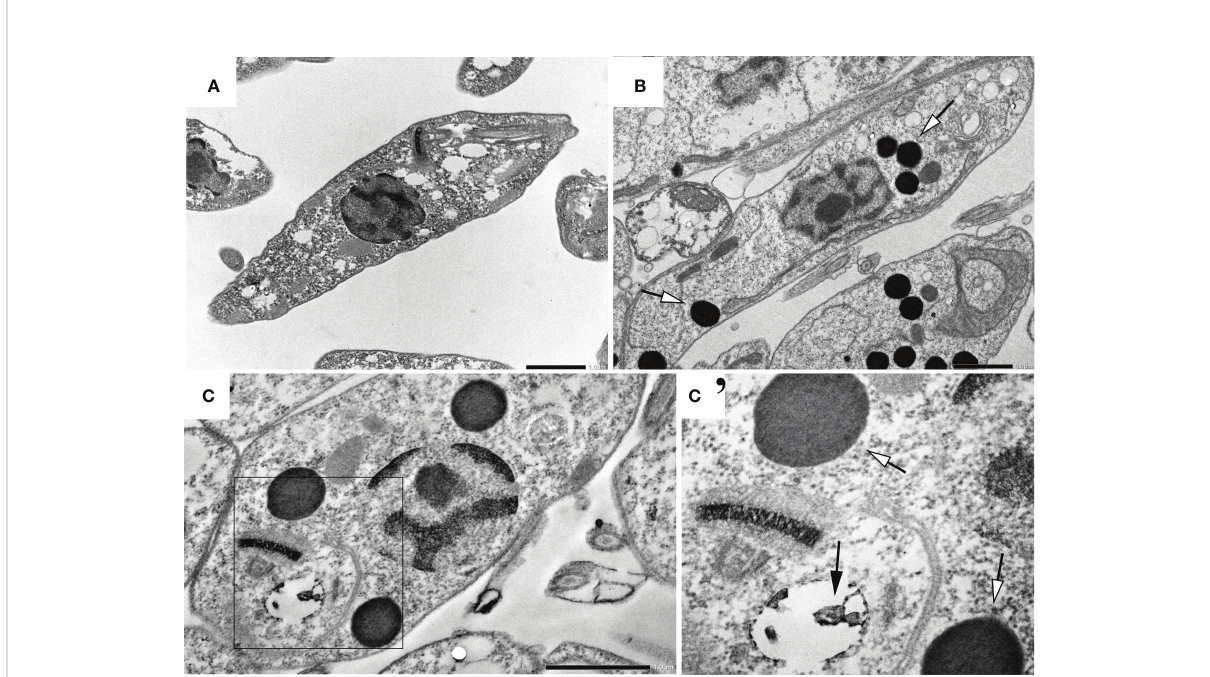
FIGURE 5 Ultrastructural analysis of L. amazonensis promastigotes treated with AmpB and TCBZ. (A) Non-treated parasites. (B) Parasites treated with AmpB IC 50 showing large electrondense vesicles (pointed by white arrowheads). (C) Parasites treated with TCBZ IC 50 . (C ’ ) Enlargement of the demarked area of Figure 3C where treated cells seem not only to present large electron-dense vesicles (white arrowheads) but also vesicles at the fl agellar pocket, which were not found in control parasites (black arrows). Bars: 1 µm.